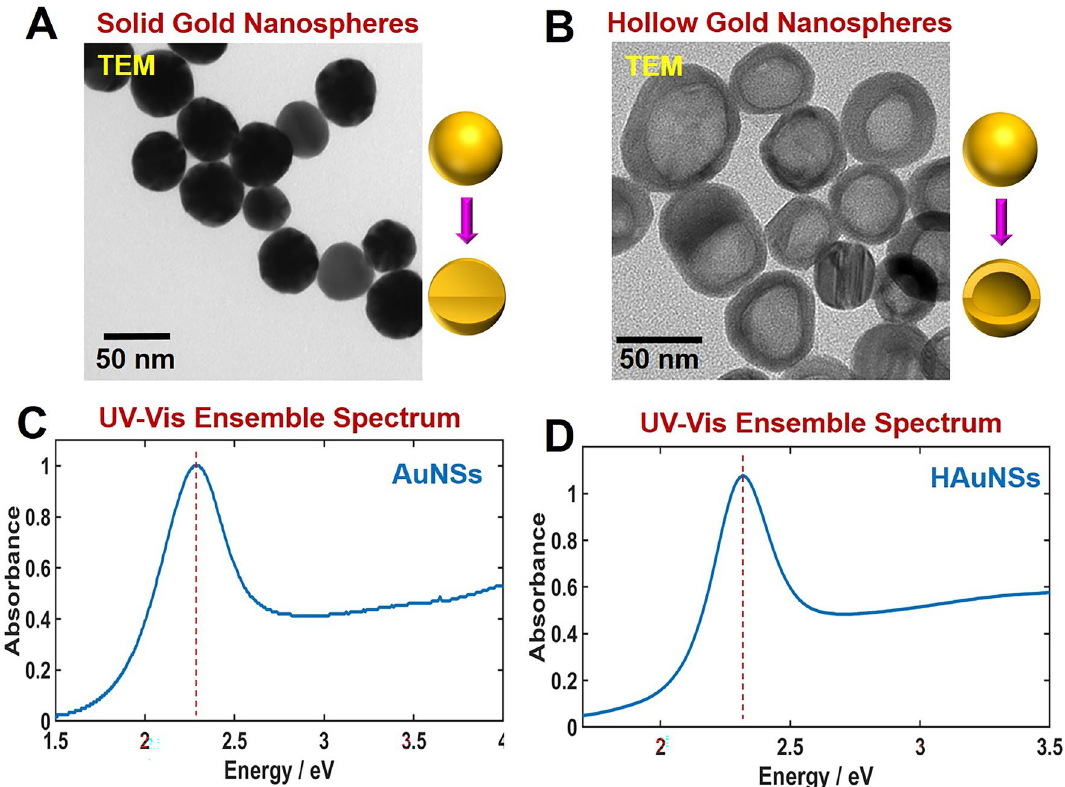
Figure 1. Representative SEM images of ( A ) AuNSs and ( B ) HAuNSs with inner cavity. UV–Vis extinction spectrum of ( C ) AuNSs and ( D ) HAuNSs dispersed in